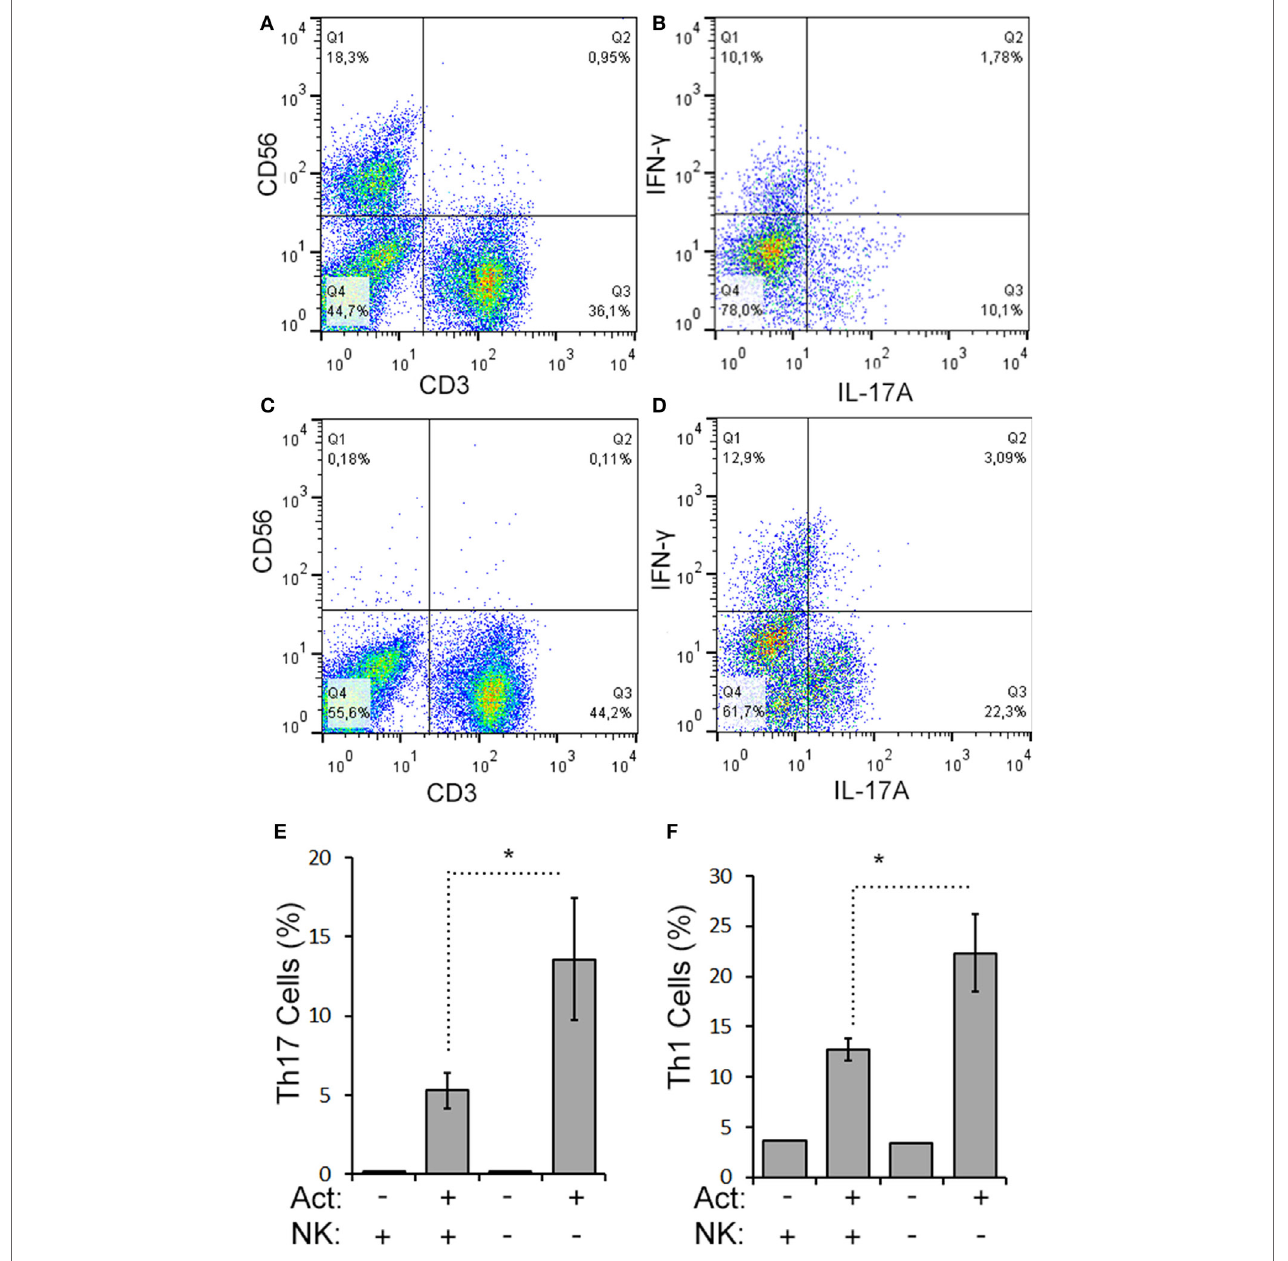
FigUre 4 | CD56 + cells suppress Th17 and Th1 cell responses in aHSCT. CD56 + cells were depleted from MS patient PBMC samples collected at 12 months post-aHSCT. Representative plots are shown for complete (a,B) and CD56-depleted samples (c,D) . Cells were activated in vitro with anti-CD3, anti-CD28, and Th17 polarizing factors (Act) for 4 days. The proportions of Th17 and Th1 cells were assessed by analysis of cytokine production by intracellular flow cytometry. Representative plots are shown for complete samples (B) and CD56-depleted samples (D) . The average proportion of Th17 (e) or Th1 cells (F) is shown. N = 3